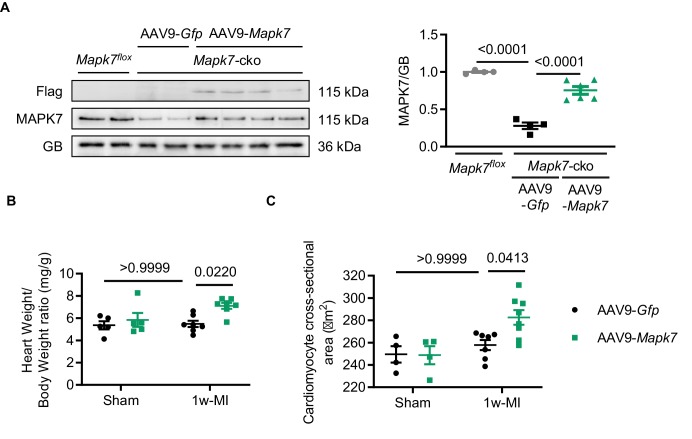
MAPK7 expression and cardiac hypertrophy in AAV9-Mapk7-injected mice one week post-MI.(A) MAPK7 expression in myocardium was restored to physiological level in Mapk7-cko mice using AAV9-Mapk7 injection (AAV9-Gfp as control) (N = 4–6 mice). Cardiac hypertrophic response was observed in Mapk7-cko hearts with restored MAPK7 expression 1 week after MI, indicated by (B) heart weight vs. body weight ratio (N = 5–7 mice) and (C) cardiomyocyte size (N = 4–7 mice). Data presented as mean ± SEM. One or two-way ANOVA followed by Bonferroni post hoc tests were employed as appropriate.Figure 5—figure supplement 1—source data 1.MAPK7 expression and cardiac hypertrophy in AAV9-Mapk7-injected mice one week post-MI.